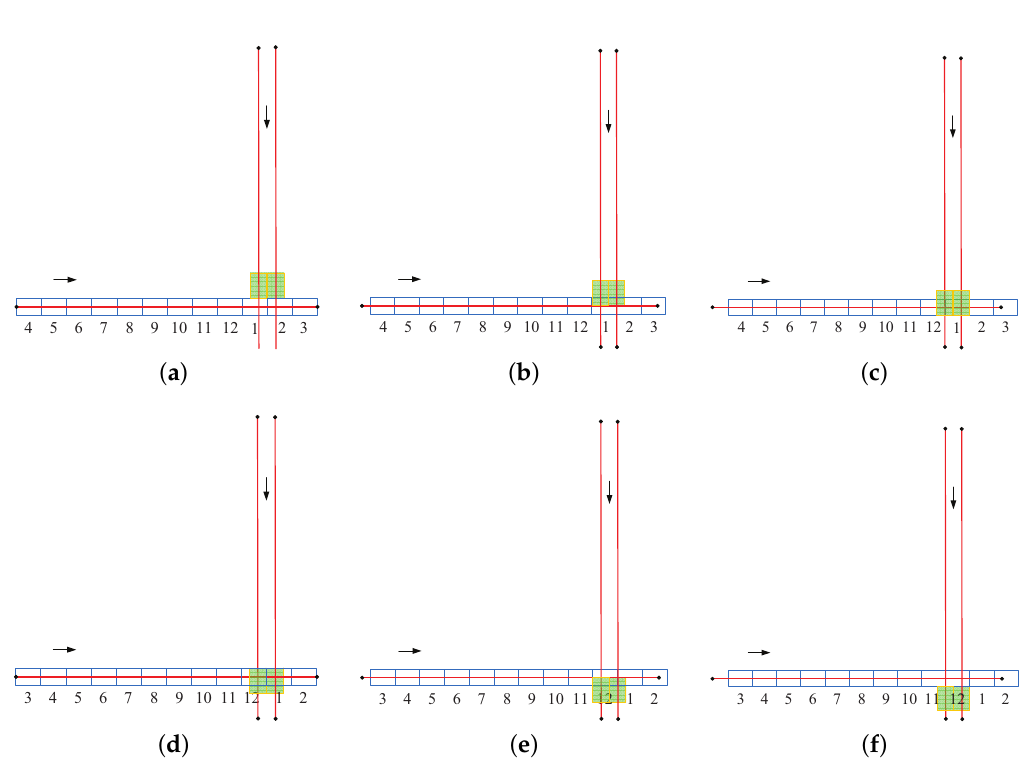
Figure 11. Motion of a VB and two VGs Motion of a VB and two VGs, ( a ) t = 28 s, ( b ) t = 29 s, ( c ) t = 0 s, ( d ) t = 31 s, ( e ) t = 32 s, ( f ) t = 33